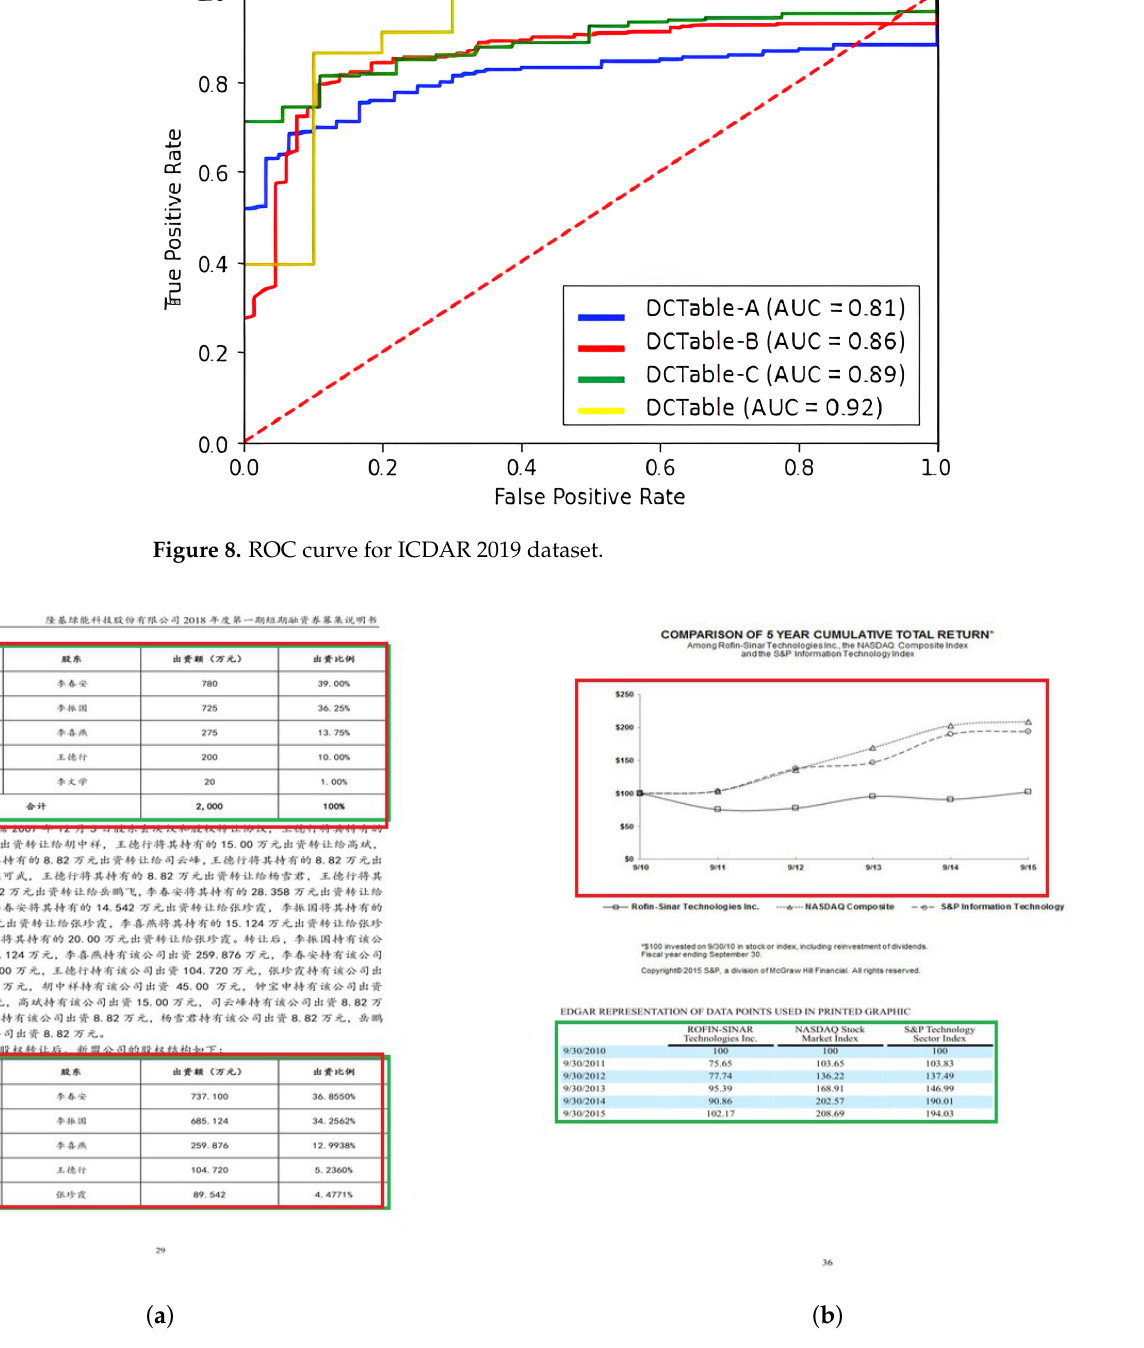
Figure 9. Some sample images from modern ICDAR 2019 showing: ( a ) true positive and ( b ) false positive. The green region represents the ground truth bounding boxes while the red region represents bounding boxes of detected